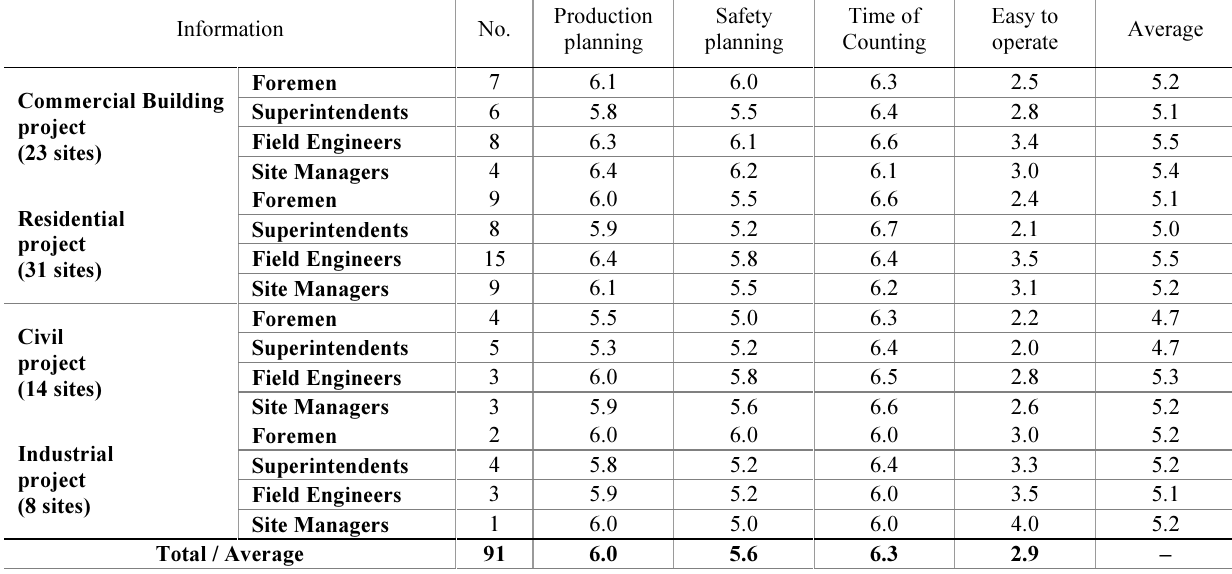
Table 4 . Survey result on benefits with the proposed system Information